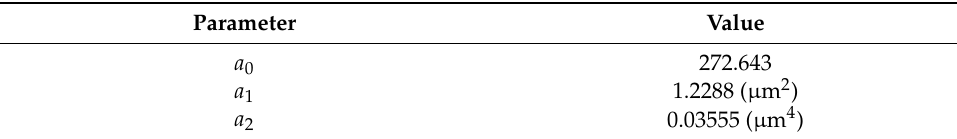
Table 2. Constants for variation of refractive index, n , see Equation (12). Parameter